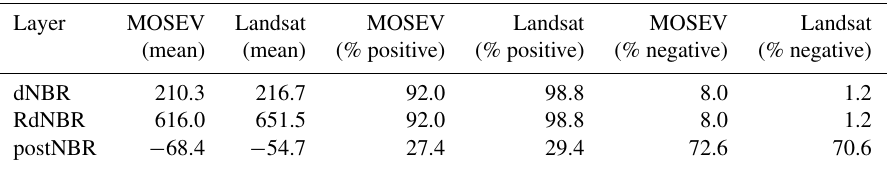
Table 2. Mean values and proportion of positive and negative values of the burn severity spectral indices included in the MOSEV database (dNBR, RdNBR and post-burn NBR spectral indices) and the equivalent obtained from 13 Landsat-8 scenes randomly distributed across the globe ( n =